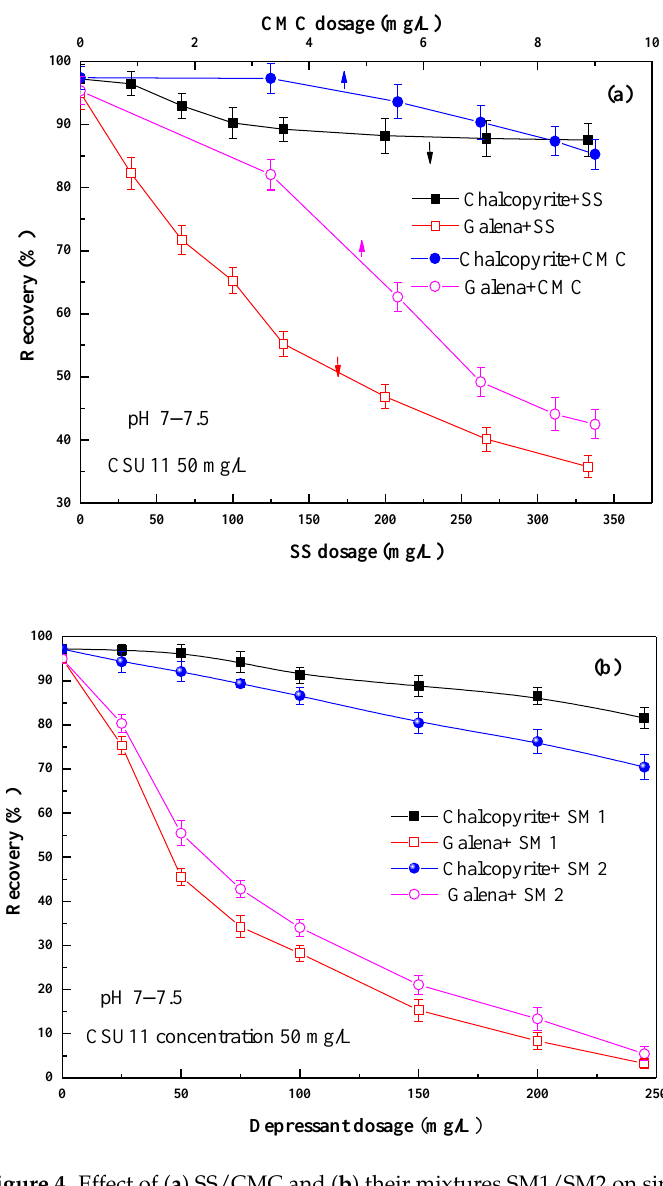
Figure 4. Effect of ( a ) SS/CMC and ( b ) their mixtures SM1/SM2 on single mineral flotation behavior. D Final ) concentration on chalcopyrite and galena flotation at natural pH (pH 7–7.5). The mixed depressant D Final selectively depressed galena. The effect was significant: galena recovery rapidly decreased with increasing depressant concentration until 900 mg/L (at which the recovery of galena was 3.3%), with little effect on chalcopyrite flotation (the recovery of chalcopyrite was 93%). As the concentration of mixed depressant D Final was increased further, the recovery of chalcopyrite decreased to some